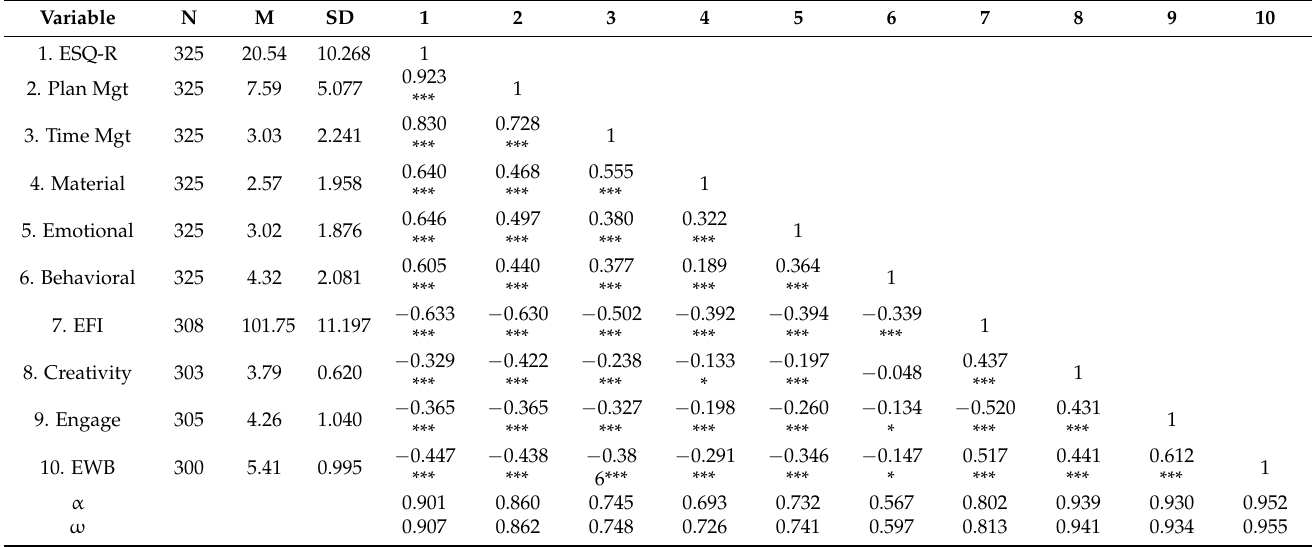
Table 3. Descriptive and Intercorrelations of Study